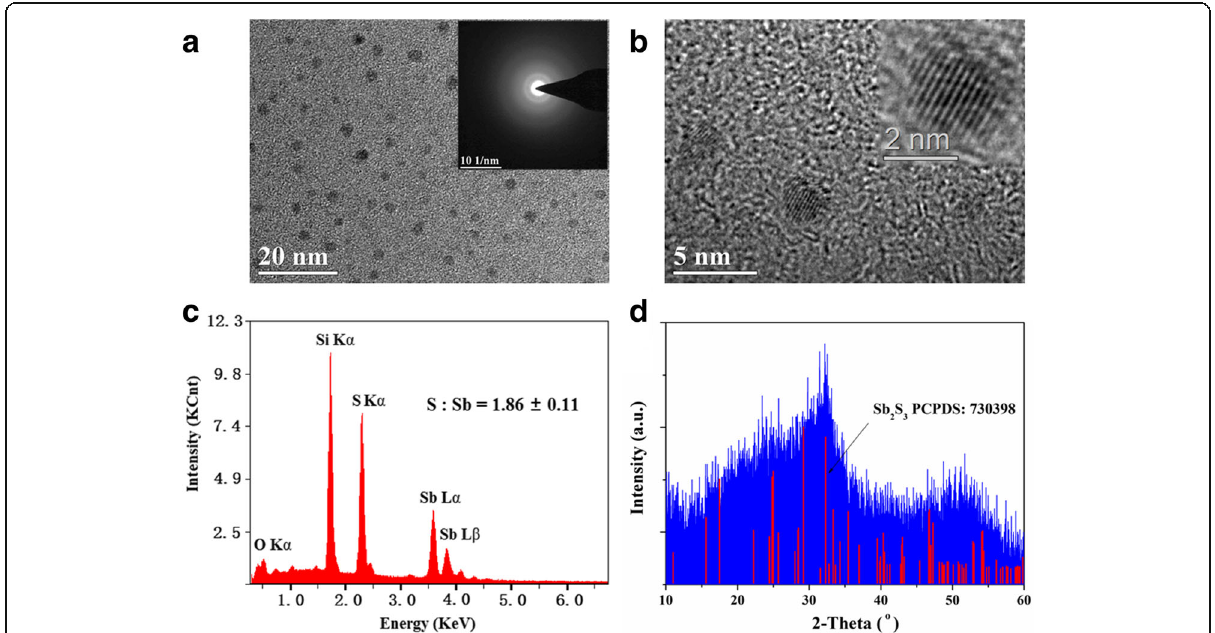
Fig. 1 Morphology and structural properties of Sb 2 S 3 QDs. a TEM image and SAED pattern. b High-resolution TEM image. c EDS analysis and d XRD